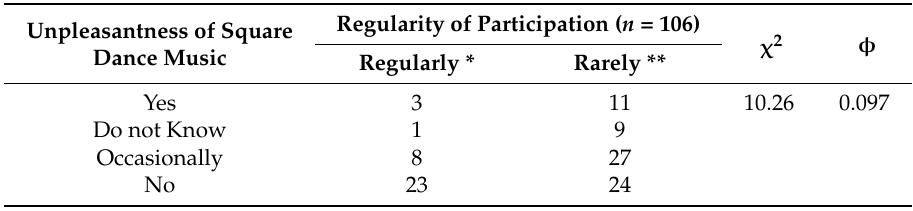
Table 11. Chi Squared Test comparing regularity of participation in Square Dance Activities to the perceived unpleasantness of the square dance